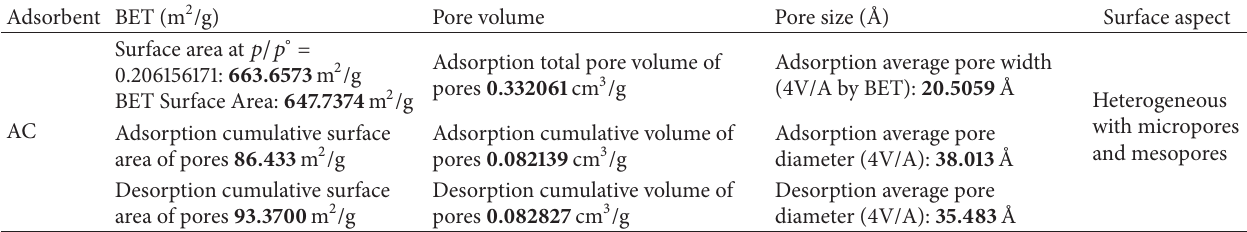
Table 1: Summary of the BET (m 2 /g), pore volume (cm 3 /g), pore size (˚A) and surface aspect of the chemically prepared activated carbon by from cola nut ZnCl 2